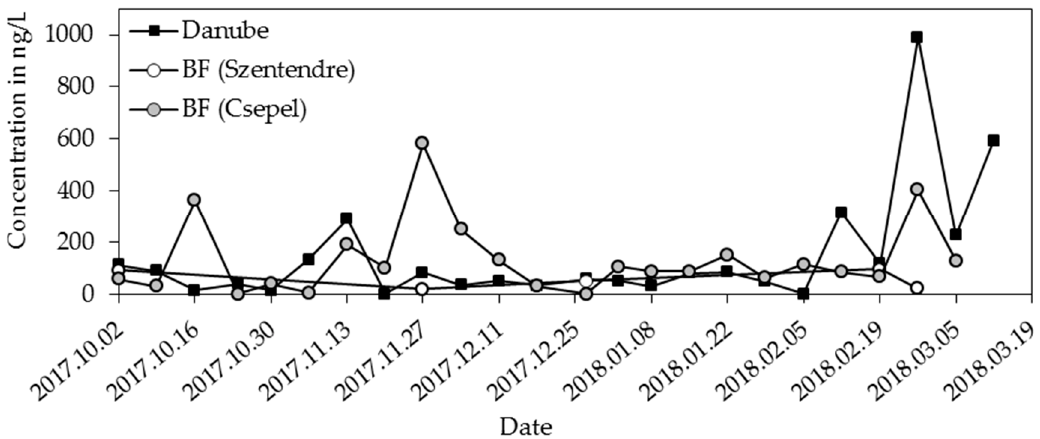
Figure 3. Seasonal fluctuation of bisphenol A concentration in Danube River water (squares) and bank filtrate (circles) (outlier of 2381 ng/L in BF (Csepel) on 26 February 2018, not shown).